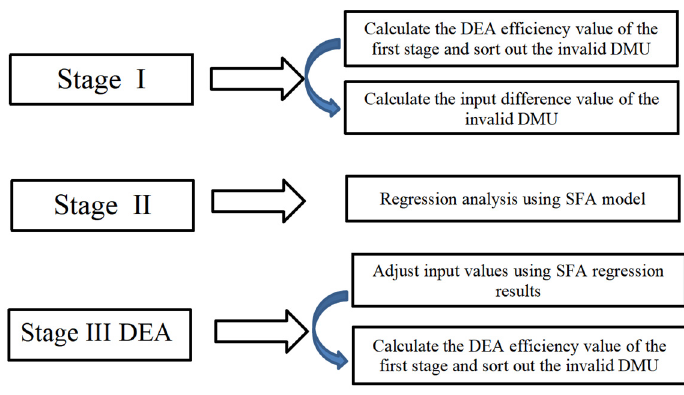
Figure 2. Three-stage DEA process.